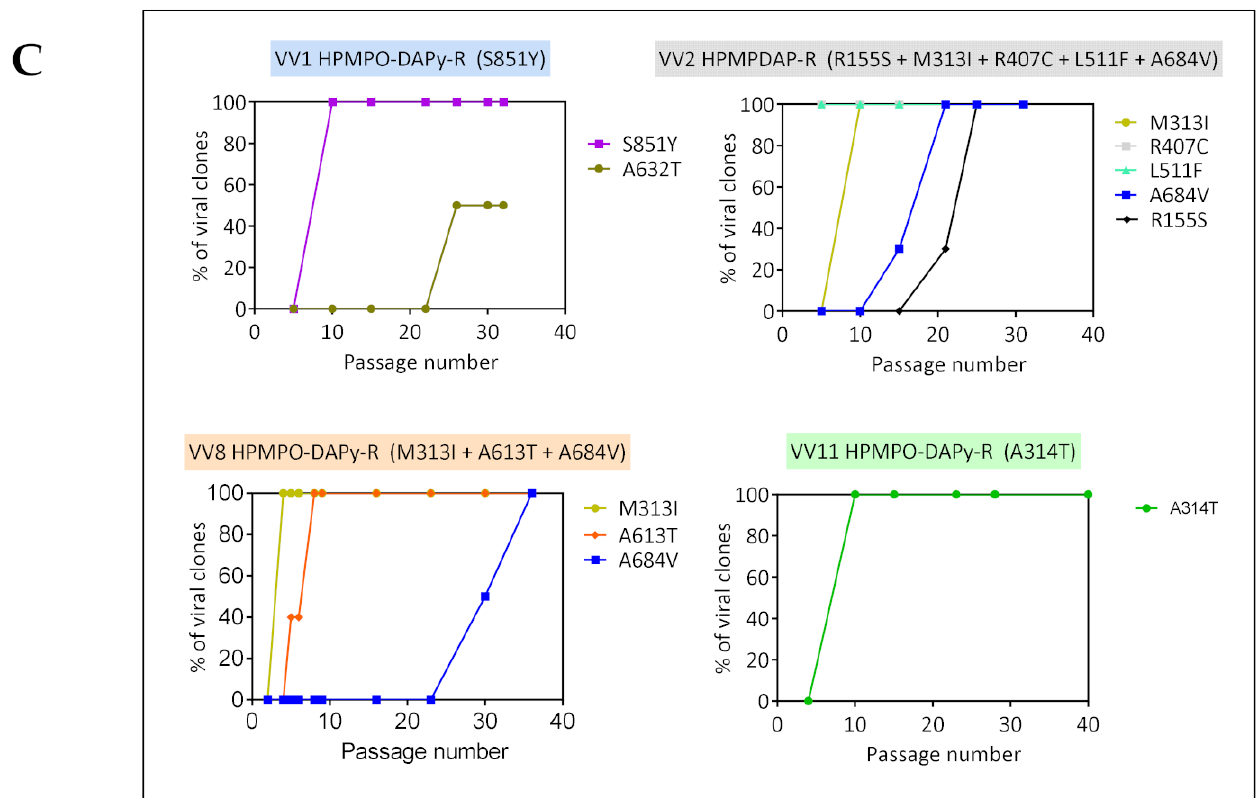
Figure 3. Chronological detection of DNA pol mutants arising at different passages under pressure of HPMPC ( A ), HPMPDAP ( B ), and HPMPO-DAPy ( C ). Viral clones were isolated at different passages during the selection procedure and genotyping of the E9L (DNA pol) gene was carried out. The percentage of clones harboring a specific mutation is shown for the different